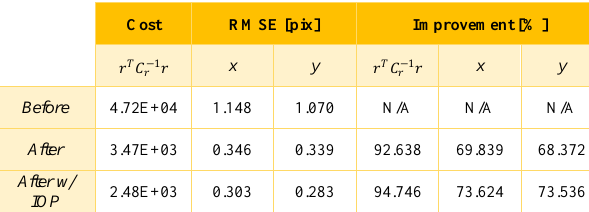
Table 1: Reprojection errors of fluoroscopic system 1